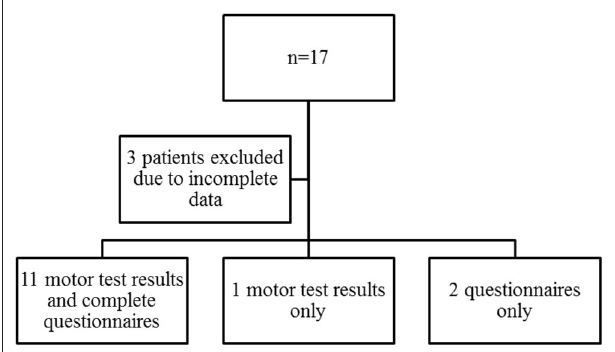
FIGURE 2 | Inclusion